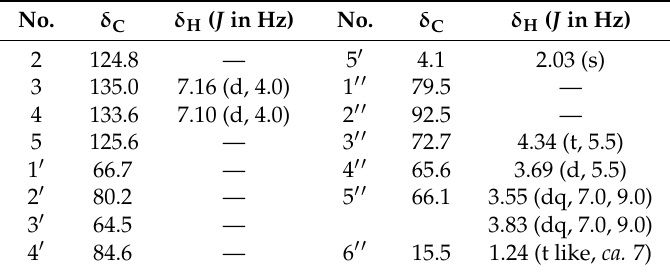
Table 3. 1 H- and 13 C-NMR data for 3 in CD 3 OD.